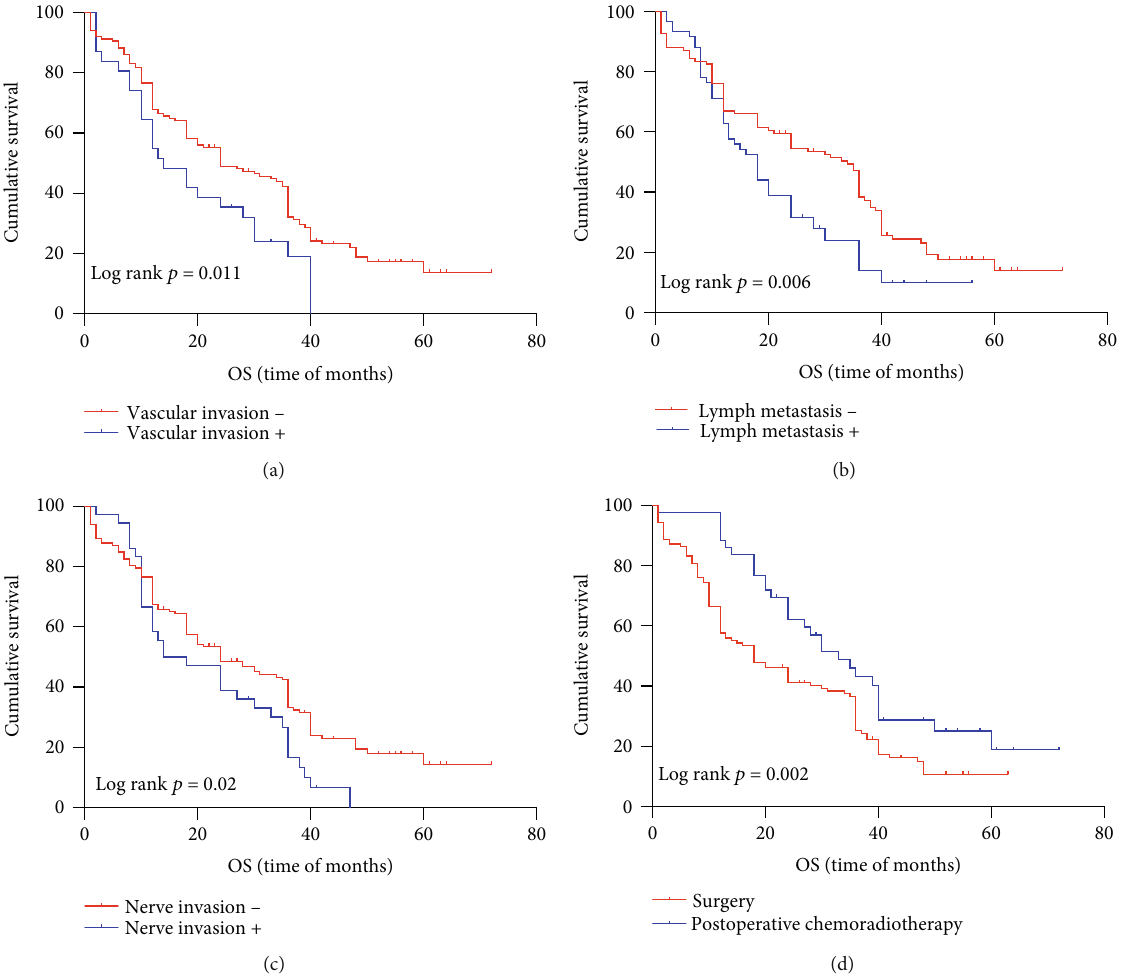
Figure 3: Kaplan – Meier curves for overall survival of ESCC with lymph node metastasis, vascular invasion, nerve invasion, and the treatment of surgery plus chemotherapy. (a) Patients with vascular invasion have a signi fi cantly shorter survival ( p = 0 : 011 ); (b) patients with lymph node metastasis have a signi fi cantly shorter survival ( p = 0 : 006 ); (c) patients with nerve invasion have a signi fi cantly shorter survival ( p = 0 : 02 ); (d) patients who had postoperative chemoradiotherapy have a signi fi cantly longer survival ( p = 0 : 002